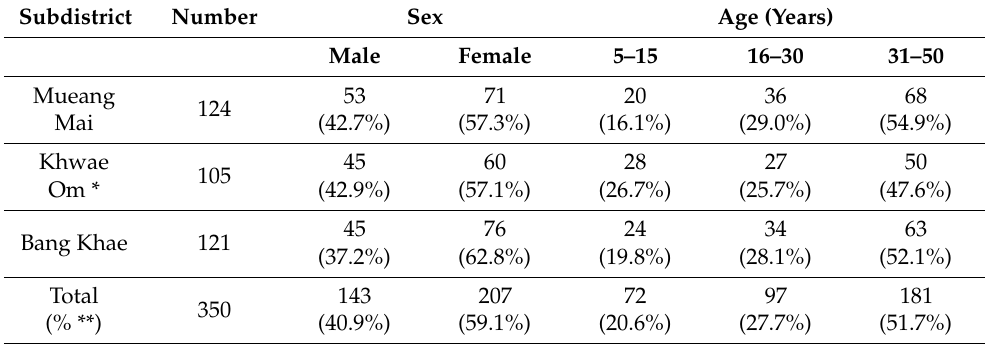
Table 1. The demographic characteristics of the study subjects.